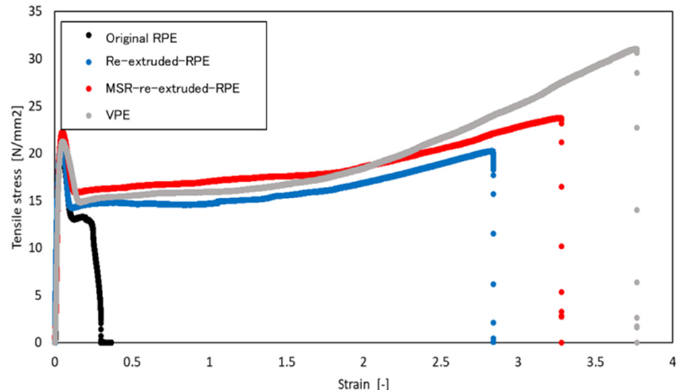
Figure 3. Representative tensile stress–strain curves for each modeled sample. The data for the original recycled polyethylene (RPE), re-extruded RPE, molten resin reservoir (MSR) re-extruded RPE, and virgin PE (VPE) are shown in black, blue, red, and grey, respectively.